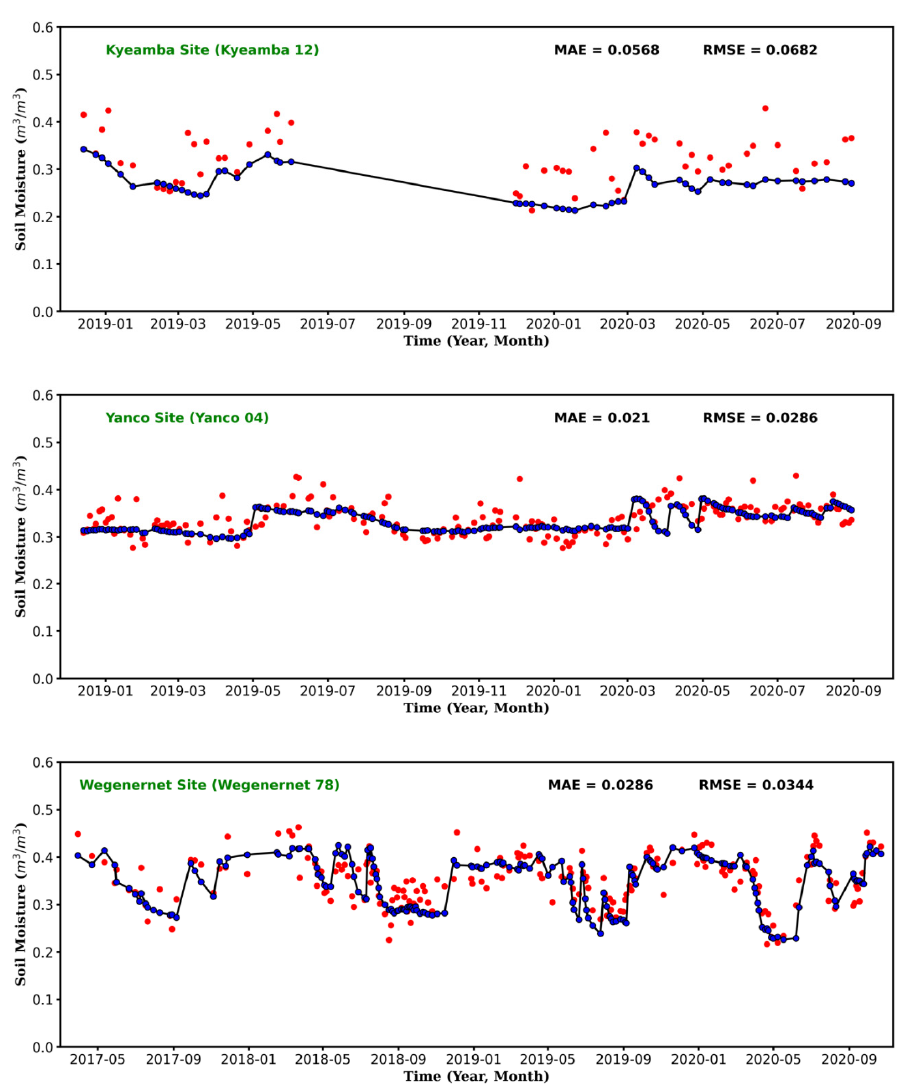
Figure 6. Soil moisture time series derived from the CNN architecture (3) for three locations. The black line with the blue points is in-situ soil moisture, and the red points are predicted soil moisture by the proposed CNN algorithm.